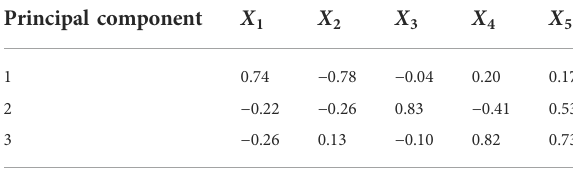
TABLE 2 Proportion coef fi cient of the principal component. Principal